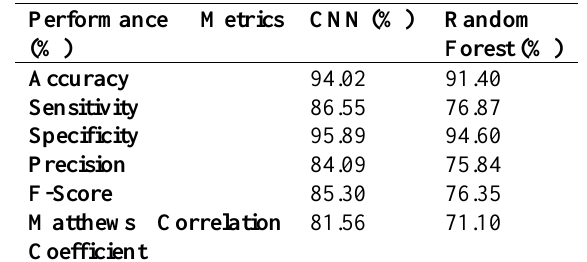
Table 1. Performance Metrics for CNN and Random